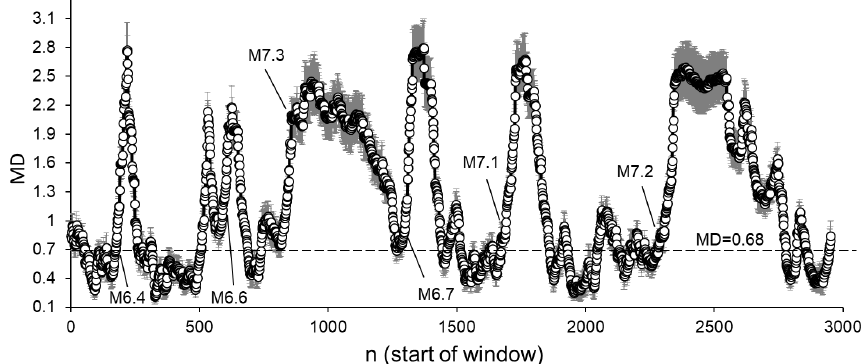
Figure 16. Average MD values calculated by comparing ICT( i ), ICD( i ), and ICE( i ) sequences from the original SC catalogue and from the set of randomised catalogues (completeness threshold M 3 . 6). The dotted line corresponds to a significant difference between windows at p = 0 . 01. MD values are calculated for 50-data windows shifted by one data step.